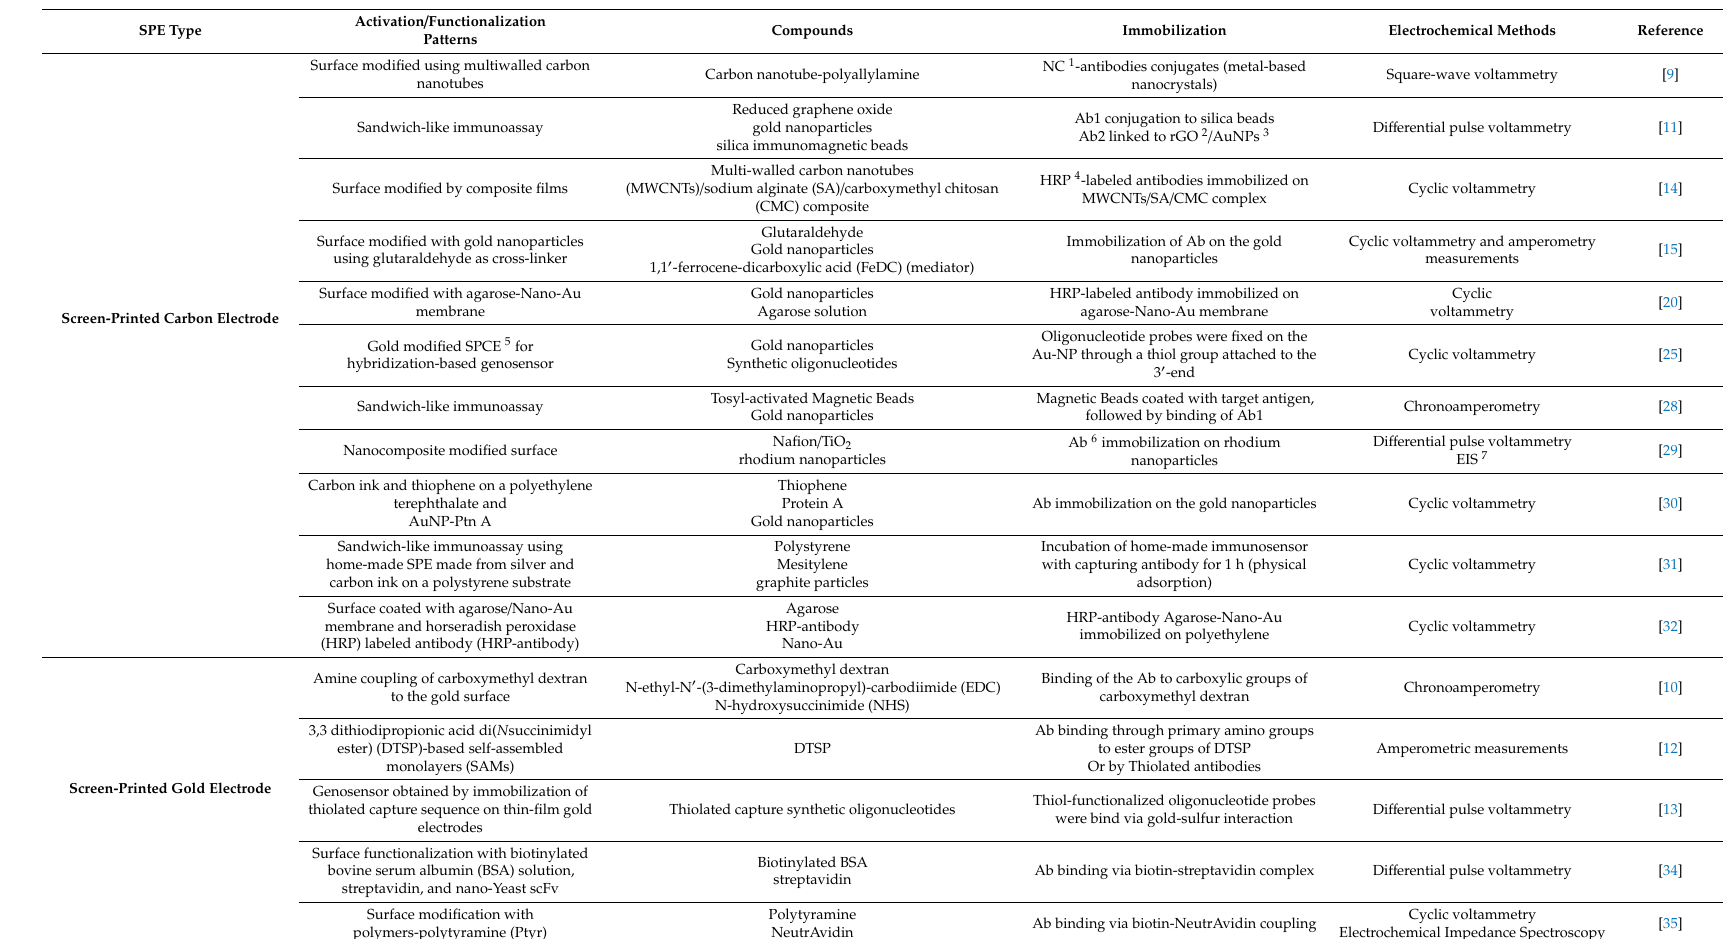
Table 1. Functionalization of various screen-printed electrodes (SPEs) to detect